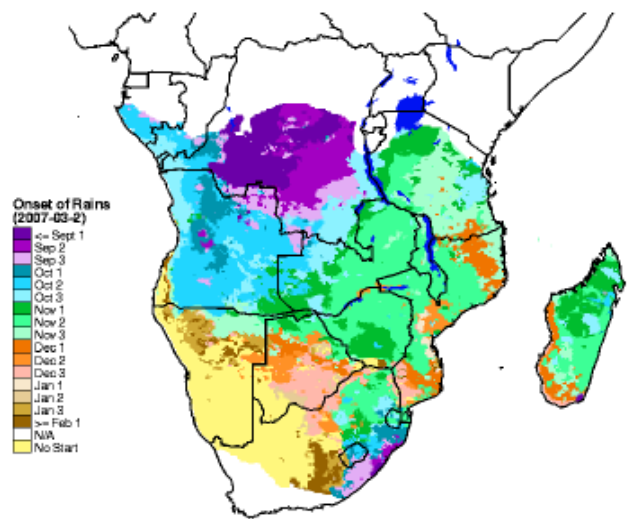
Figure 10. Onset of rains map for southern Africa for the 2006/2007 growing seasons as of the 2 nd dekad of March,